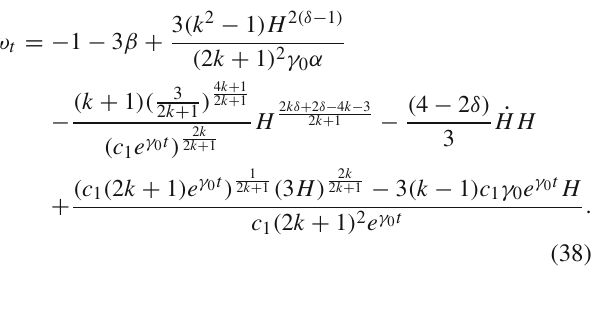
Fig. 8 Plot of EoS parameter of THDE versus redshift ( z ) for c 1 = 0 . 01, c 2 = 0 . 115, k = 0 . 325, γ 0 = 2 . 23, and α = 1 . 5, β = − 0 . 10 , − 0 . 12 , − 0 .